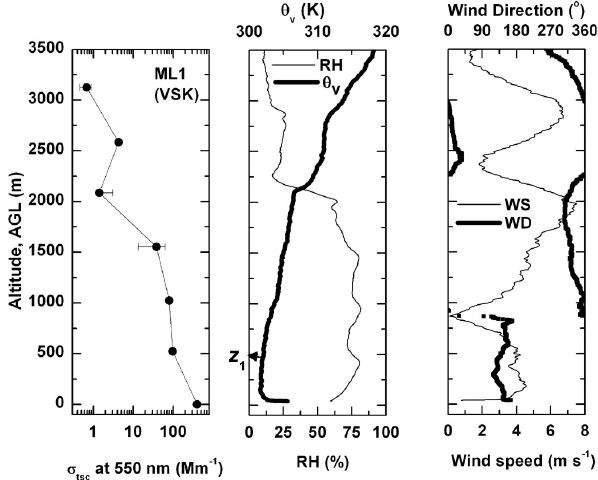
Fig. 5. Same as Fig. 3 but over PBR during